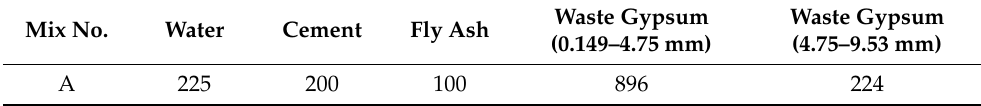
Table 1. Mix proportions (kg/m 3 ).